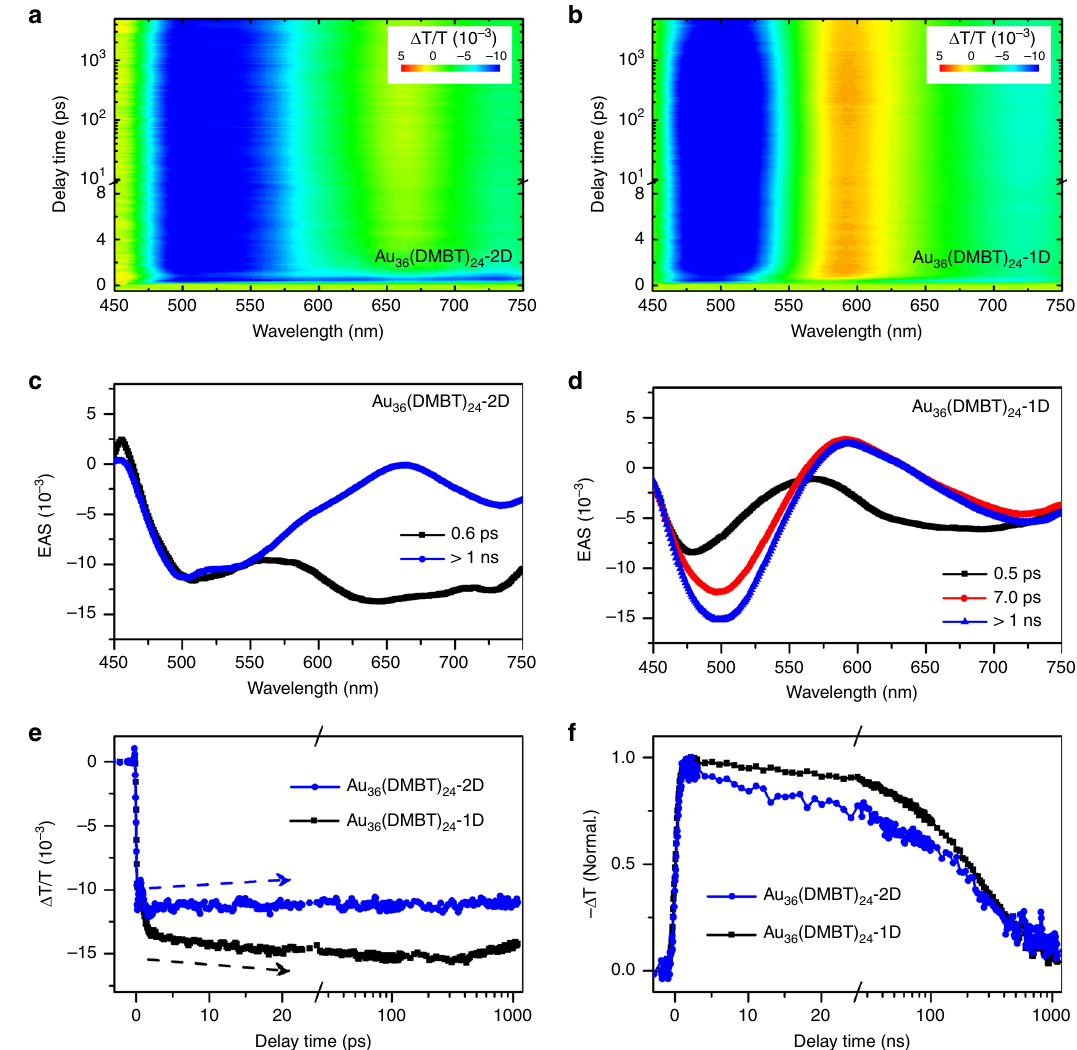
Fig. 6 Excited-state dynamics of Au 36 (DMBT) 24 nanoclusters. Femtosecond-resolved transient absorption data recorded from a Au 36 (DMBT) 24 -2D and b Au 36 (DMBT) 24 -1D. Spectral features of different delay components derived from global fi tting analysis for c Au 36 (DMBT) 24 -2D and d Au 36 (DMBT) 24 -1D. e Femtosecond-resolved and f nanosecond-resolved dynamic traces of the two